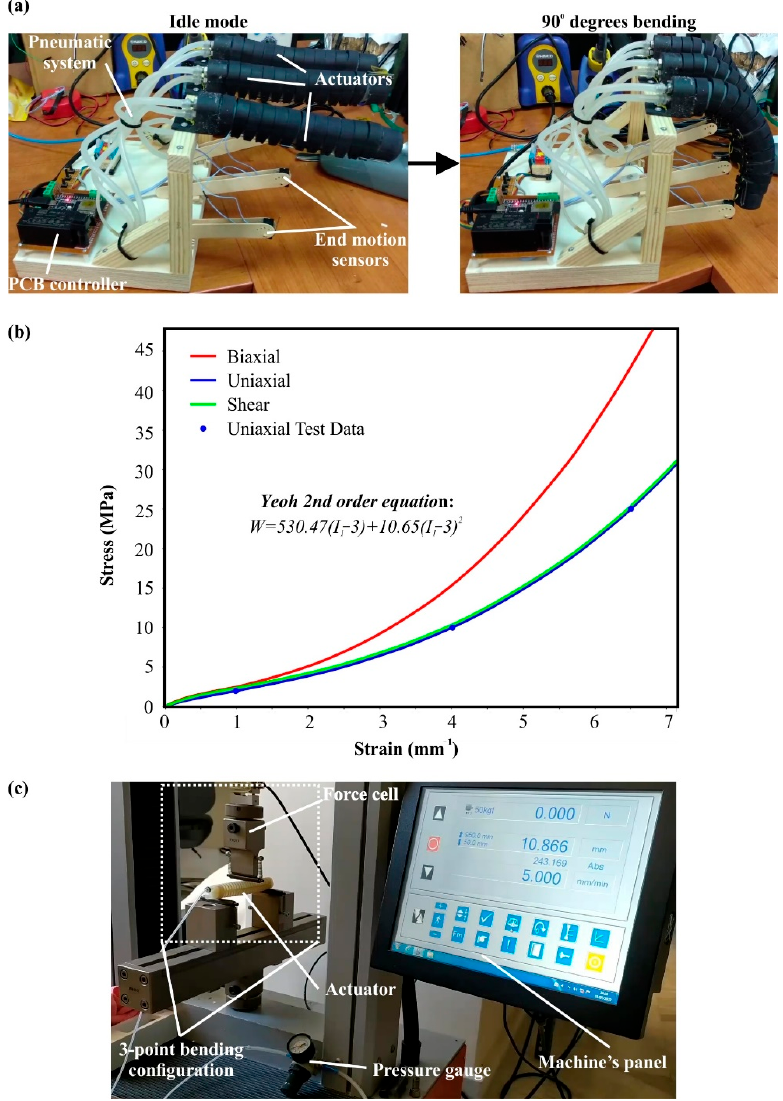
Figure 5. ( a ) Setup of the quality control process; ( b ) Yeoh 2nd order stress–strain curves for the hyper-elastic material model; ( c ) Experimental layout for the deflecting force measurements.